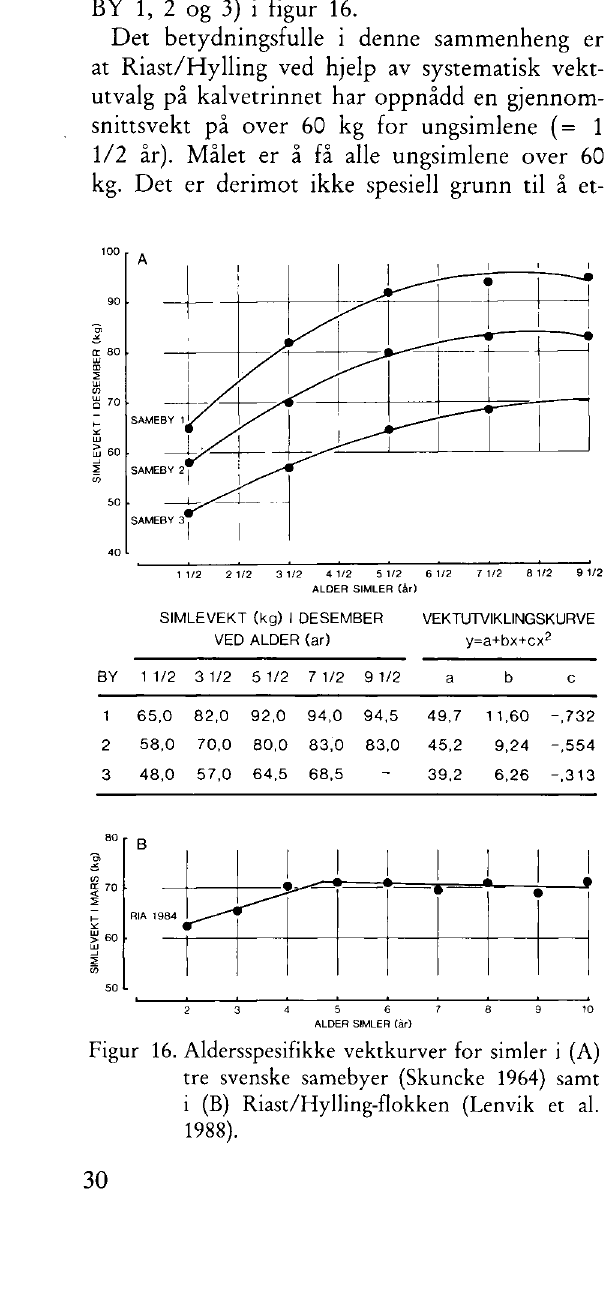
figur 15. Tross dette er aldersstrukturen i simle- flokken særdeles viktig for kalveproduksjonsre- sultatet. Høg gjennomsnittsalder for simlene le der også til høg gjennomsnittsvekt. Den alders spesifikke gjennomsnittsvekten for simlene i Riast/Hylling-flokken i 1984 (RIA 1984) er vist sammen med tre svenske simleflokker (SAME BY 1, 2 og 3) i figur 16.